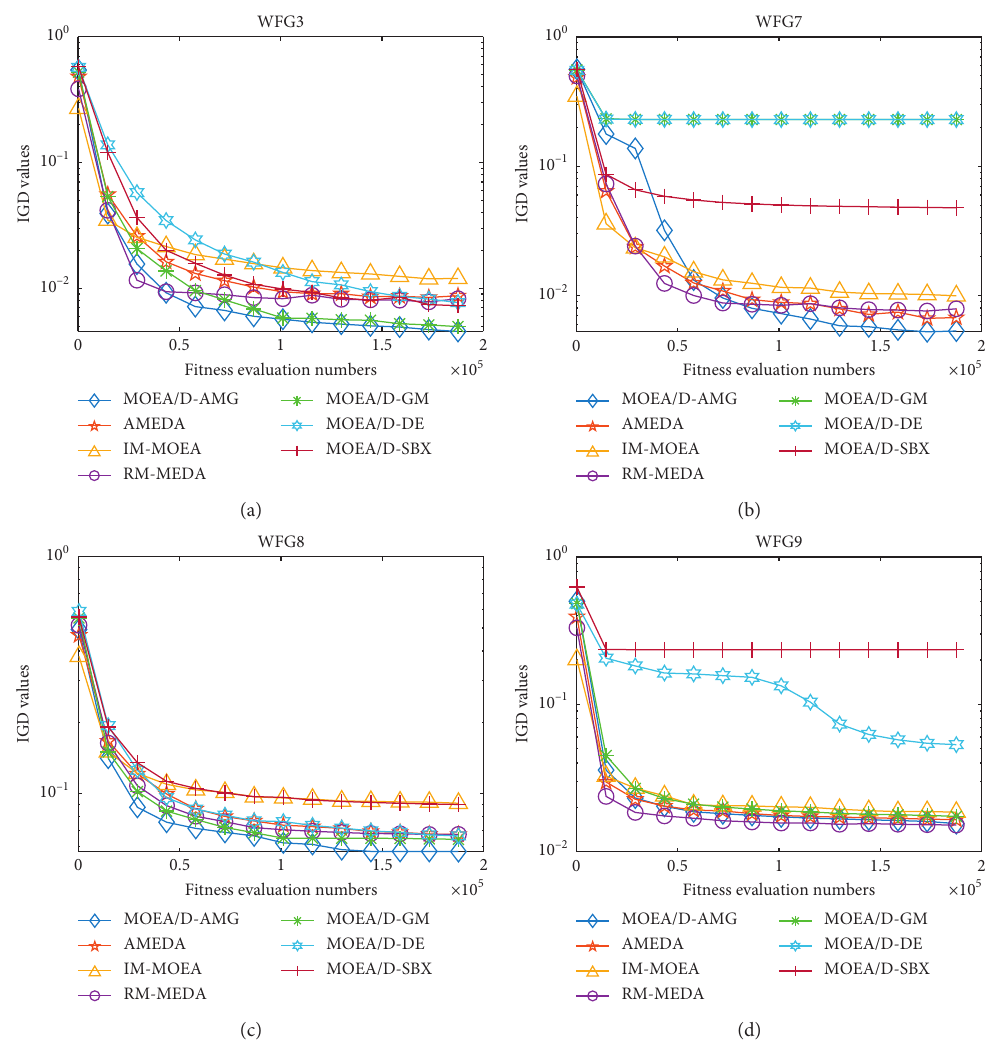
Figure 4: The convergence curves of all the compared algorithms on WFG3 and